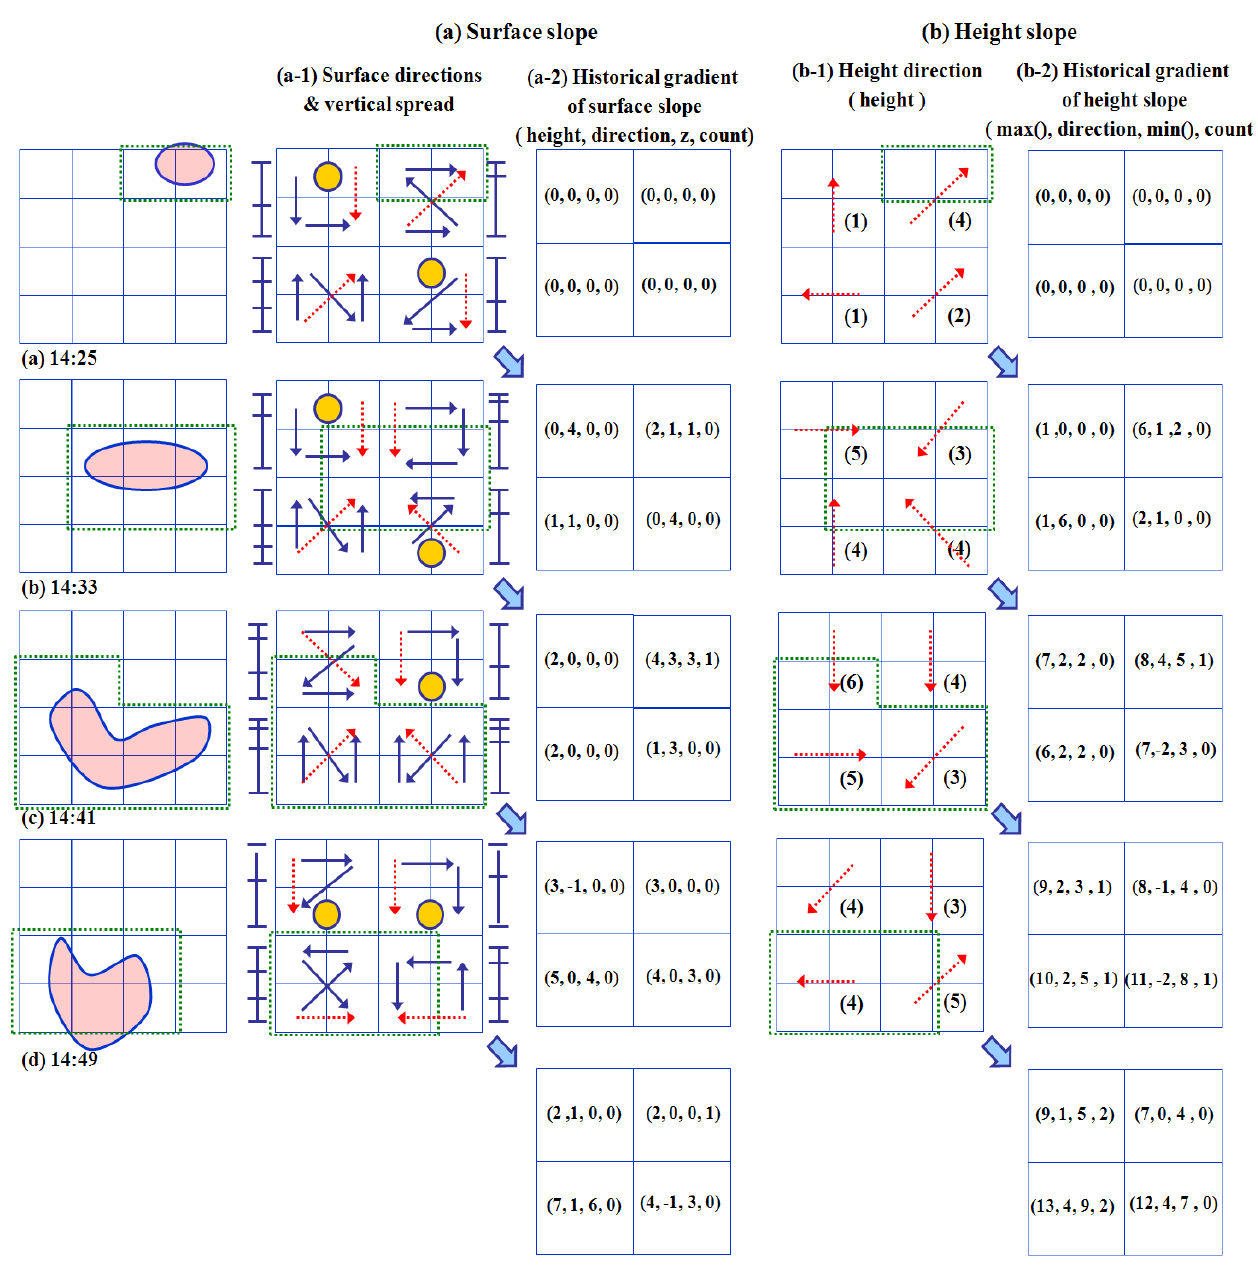
Figure 8. The representation update of the